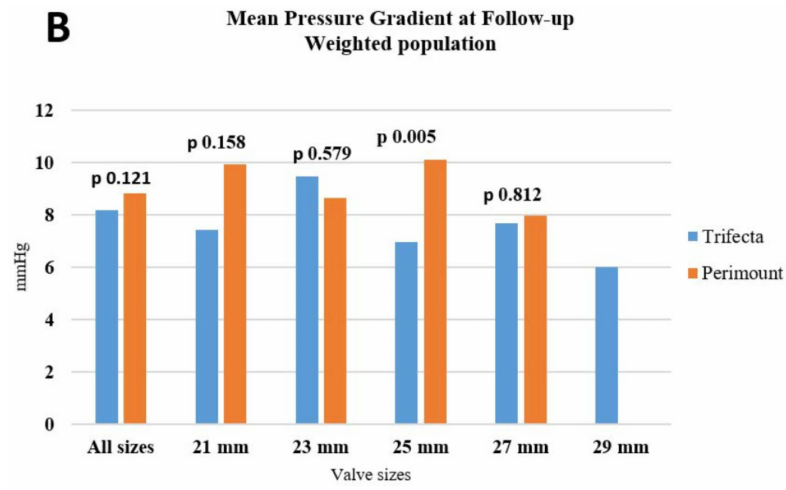
Figure 3. ( A ) Transthoracic echocardiographic assessment of the mean pressure gradient in un- weighted population at follow-up. ( B ) Transthoracic echocardiographic assessment of the mean pressure gradient in weighted population at